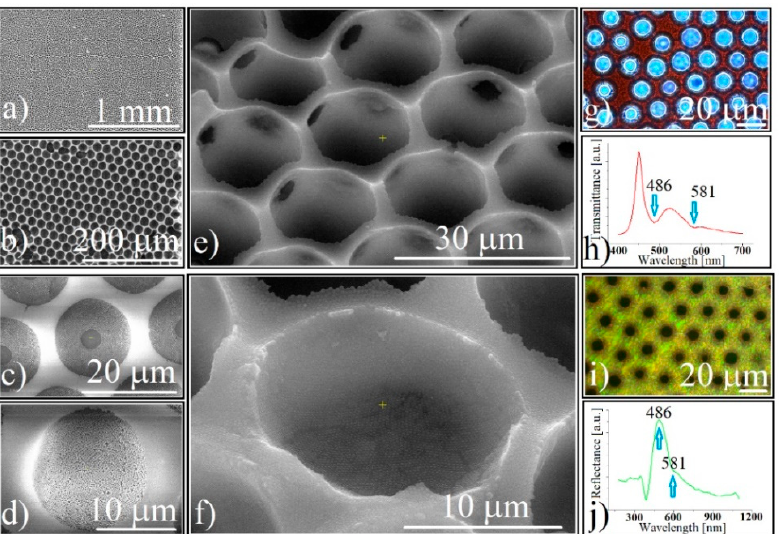
Figure 3. Direct SEM images of: ( a ) large view of silica-ordered concavity array; ( b ) silica-ordered concavity array honeycomb-like structure; ( c ) silica-ordered concavity synthesized by a sequential approach; ( d ) silica-ordered concavity synthesized by co-assembly; ( e , f ) tilted (45 ◦ ) SEM images of silica-ordered concavities; ( g ) transmission optical microscopy image of 0.264 µ m silica spheres forming ordered concavities; ( h ) transmittance of 0.264 µ m silica spheres forming ordered concavi- ties; ( i ) reflection optical microscopy image of 0.264 µ m silica spheres forming ordered concavities; ( j ) reflectance of 0.264 µ m silica spheres forming ordered